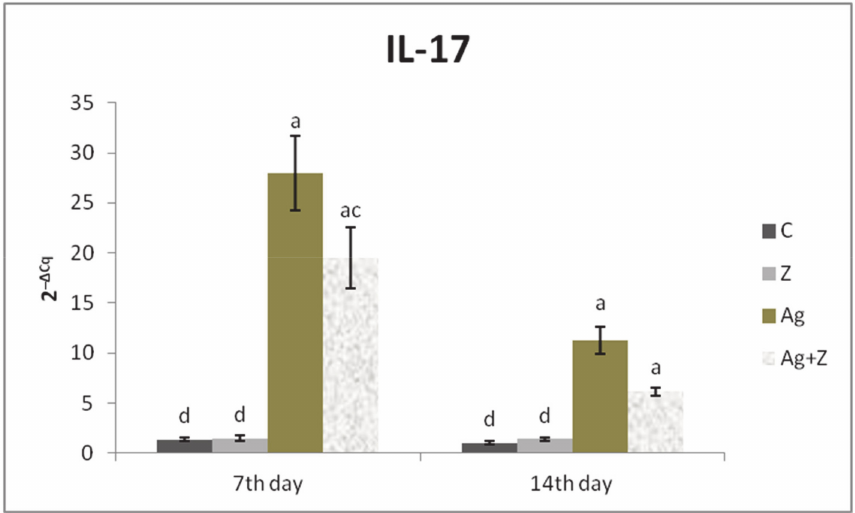
Figure 2. Relative expression of IL-17 gene in the jejunum of chickens treated with inorganic ZnSO 4 and infected by A. galli . Results at each time point are the median of 2 − ∆ Cq . Means with different superscripts are significantly different. ac p < 0.01; ad p <